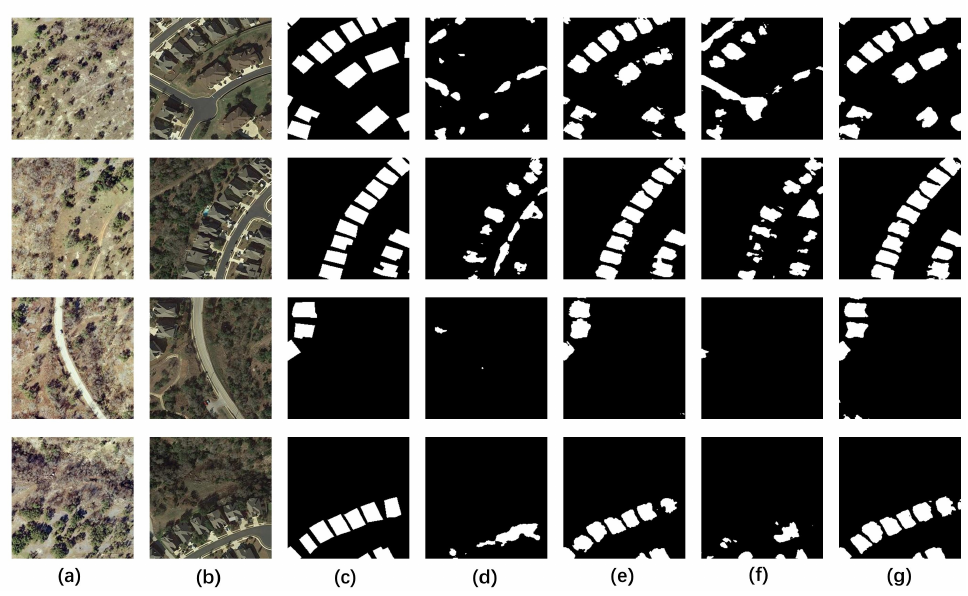
Figure 8. Visual comparison of SANet and semiSANet for CD maps on the LEVIR2000 dataset. 50 labeled images. ( f ) SANet with 100 labeled images. ( g ) semiSANet with 100 labeled images.